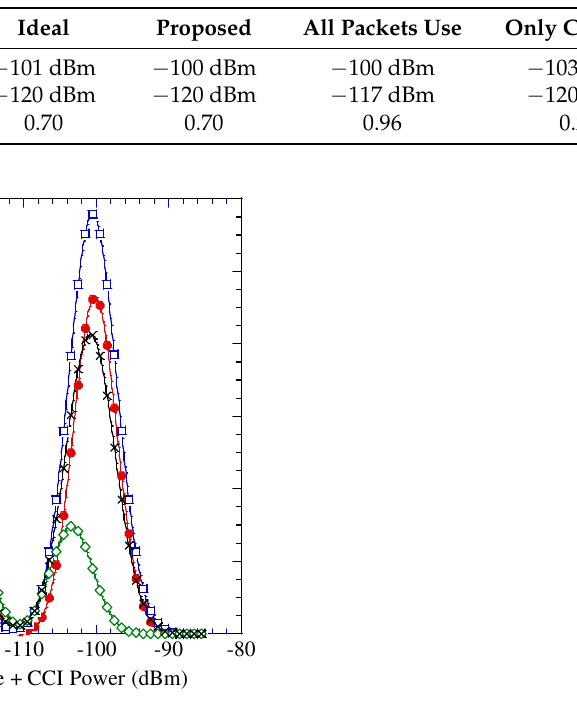
Table 2. Results of the estimated power and COR in each estimation scheme.